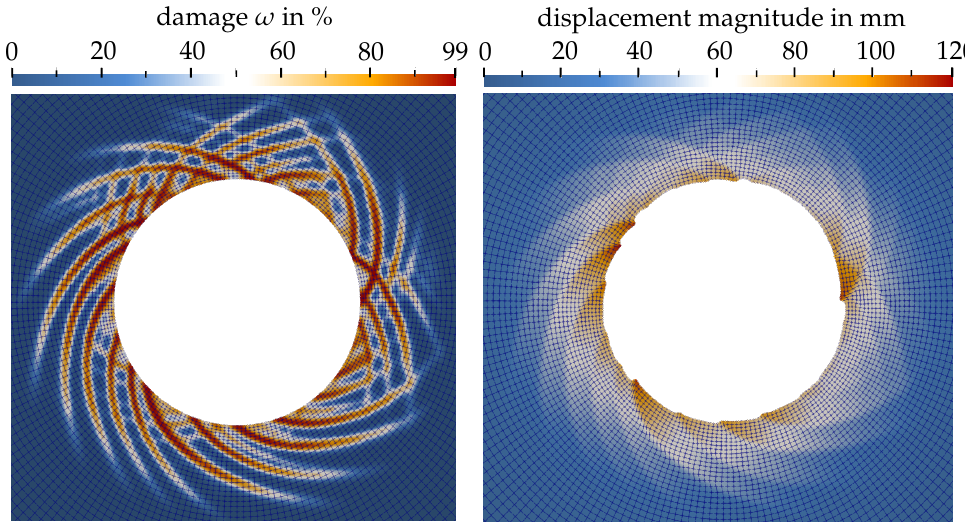
Figure 9. Distribution of the damage variable ω ( left ) and the displacement magnitude ( right ) (displacement scale factor 3) in the final stage of the tunnel simulation using the isotropic RDP model.